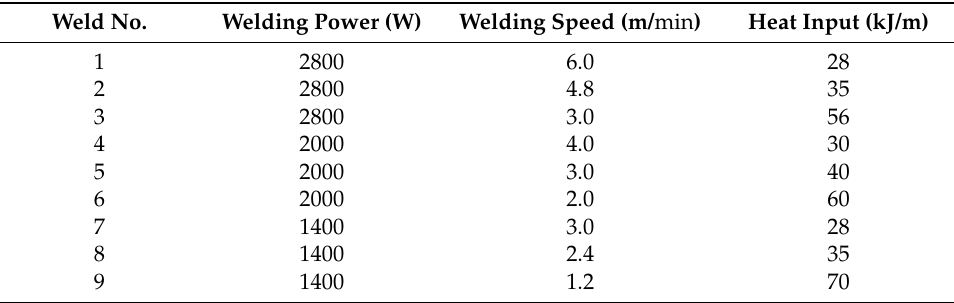
Table 2. Laser welding process